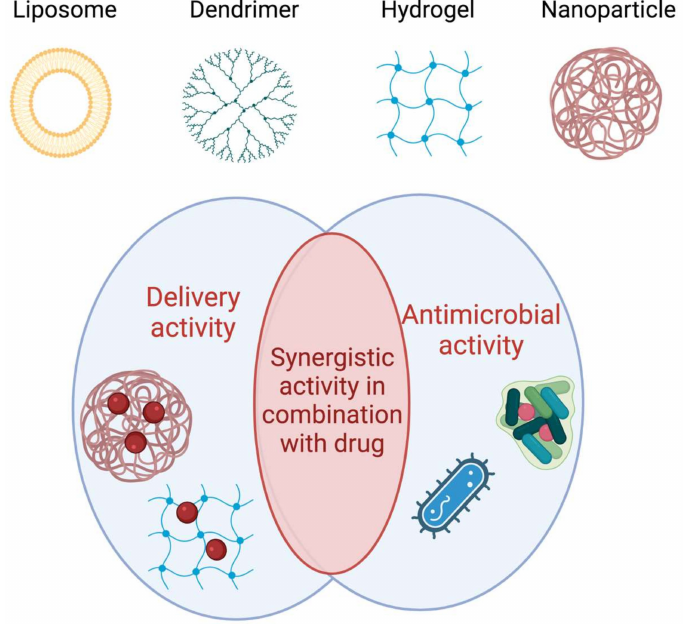
Figure 4. Illustration of main functions of some representative NVs in antimicrobial applications. NVs have both antimicrobial and delivery activities and may act with a synergistic activity in combination with other drugs. This figure was created with BioRender.com (accessed on 2 February